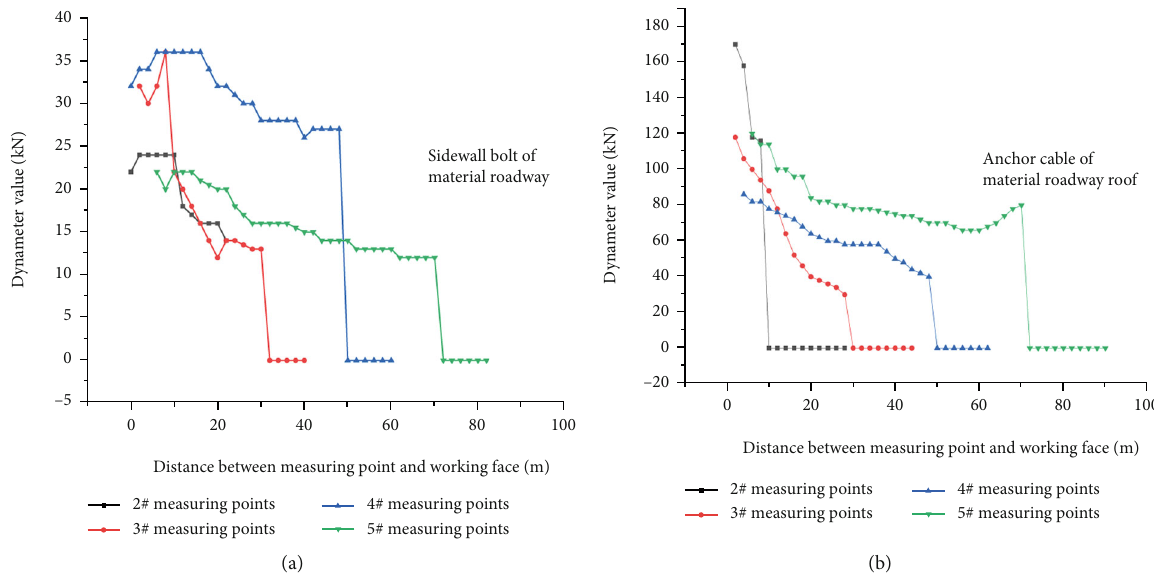
Figure 6: Relationship between pressure value of dynameter in material roadway and distance from working face.